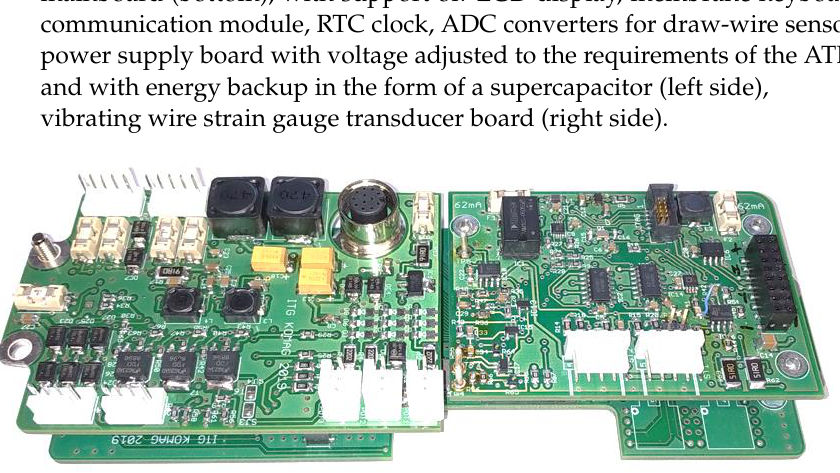
Figure 8. The hardware model of the measuring device.